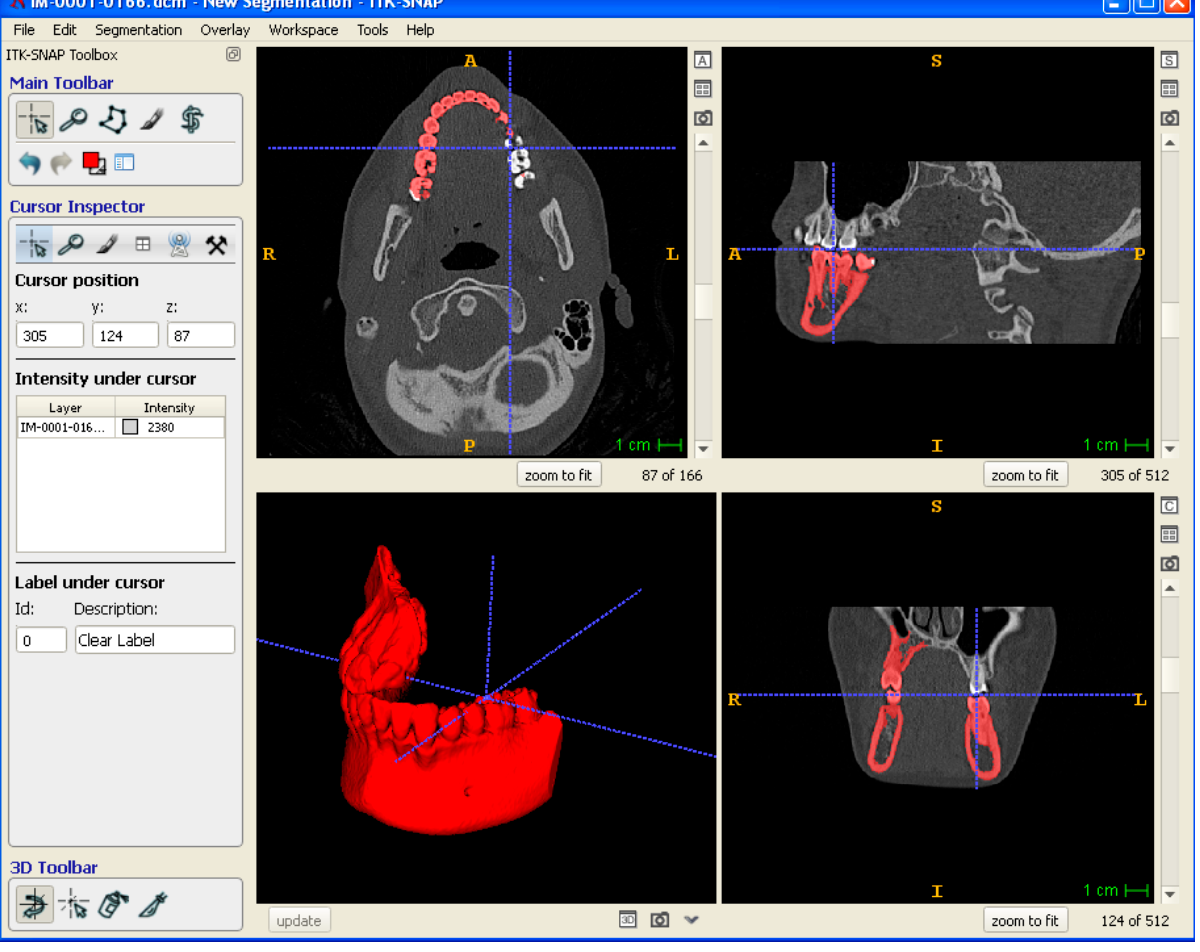
Figure 3. Digital modeling: segmentation of DICOM data to obtain a 3D Model exported in STL format.